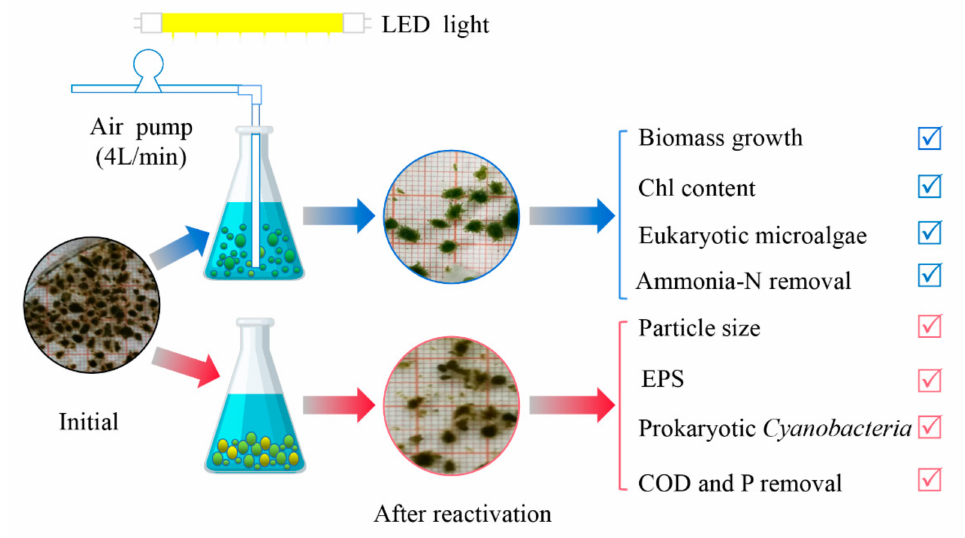
Figure 5. Overall characteristics of reactivation of frozen stored microalgal-bacterial granular sludge under aeration and non-aeration